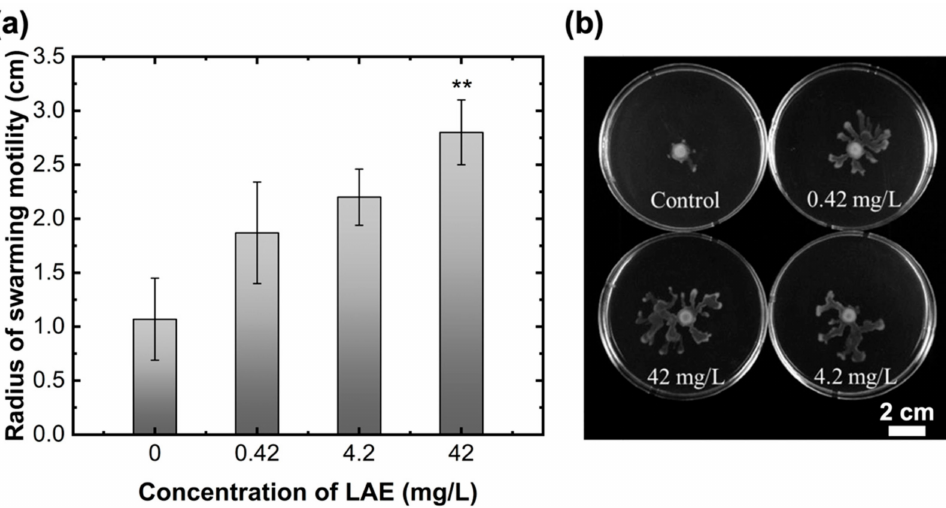
Figure 6. The radius of the swarming motility of P. aeruginosa with LAE treatment. ( a ) The radius of swarming motility as a function of different concentrations of LAE included in the BM2 swarm agar. ( b ) Colony patterns formed by swarming motility with the treatment of different concentrations of LAE. Error bars indicate standard deviations of three independent measurements. ** p < 0.005 versus